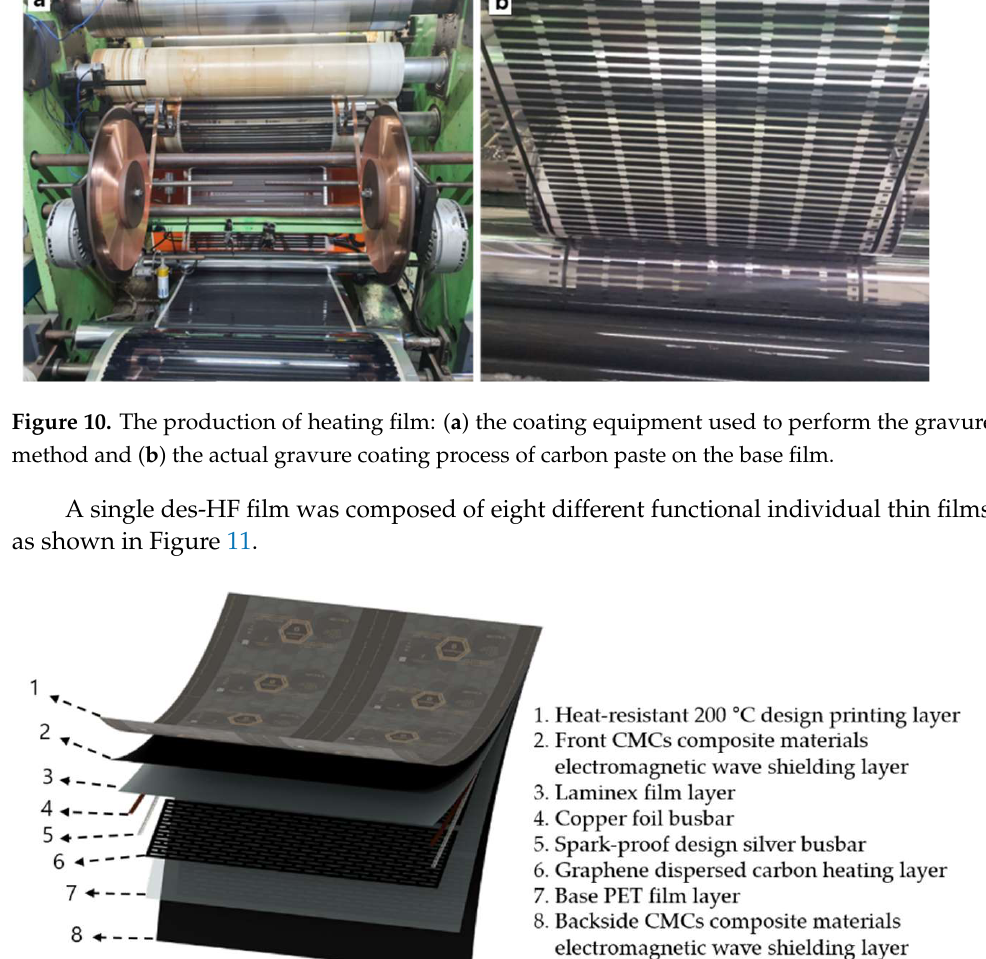
Figure 11. Structure of dual electromagnetic shielding premium heating film.